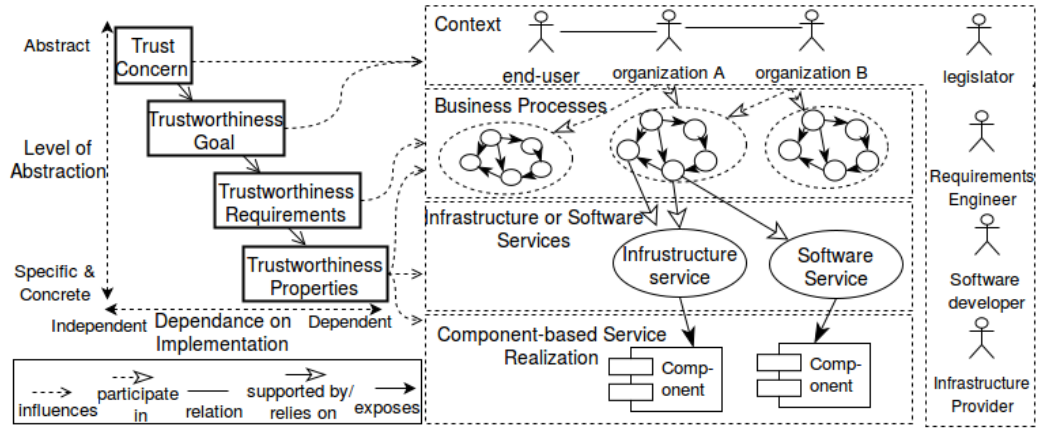
Figure 2. Placing our proposed approach for enriching business processes with trustworthiness requirements and their alignment with software